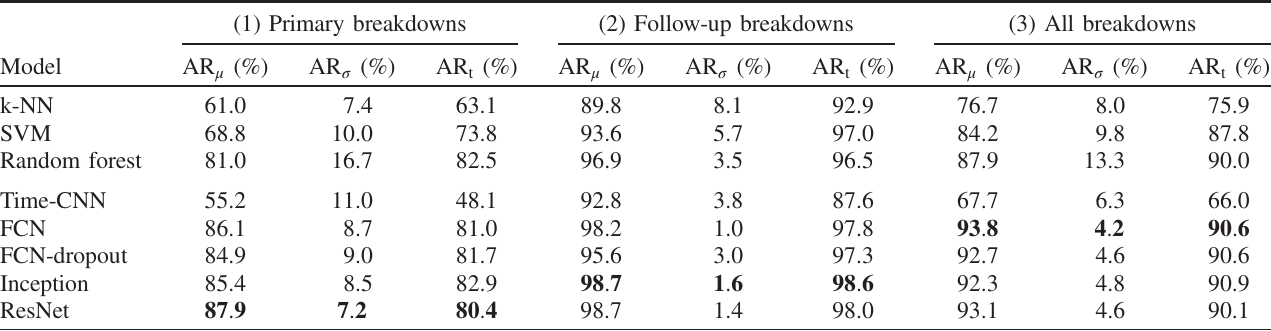
TABLE II. AR score of different models, predicting primary, follow-up, and all breakdowns with trend data. The model for each column is highlighted in bold. AR μ relates to the average AR score of different validation sets and AR σ to the standard deviation. The trained model is finally tested on the test set with a performance AR t